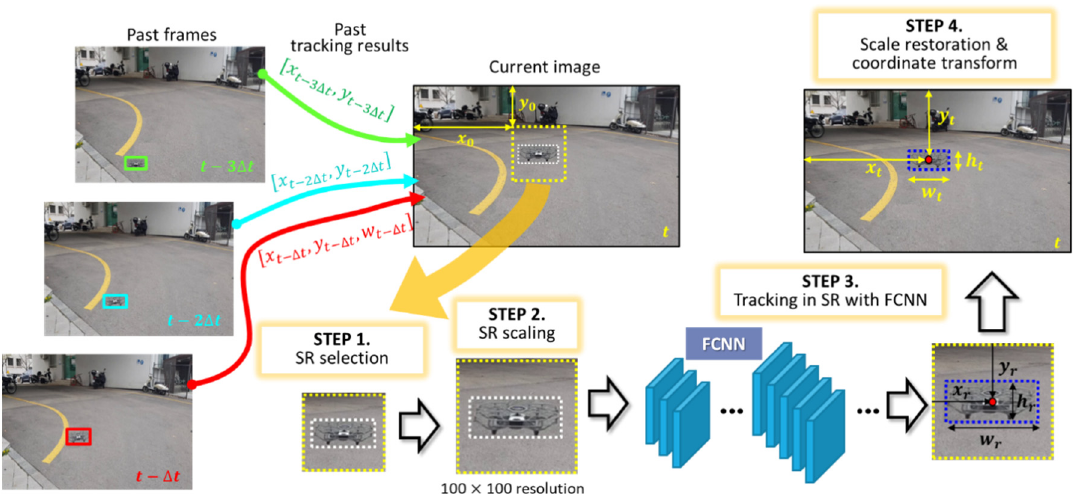
Figure 1. Procedure of tracking with search region (SR).